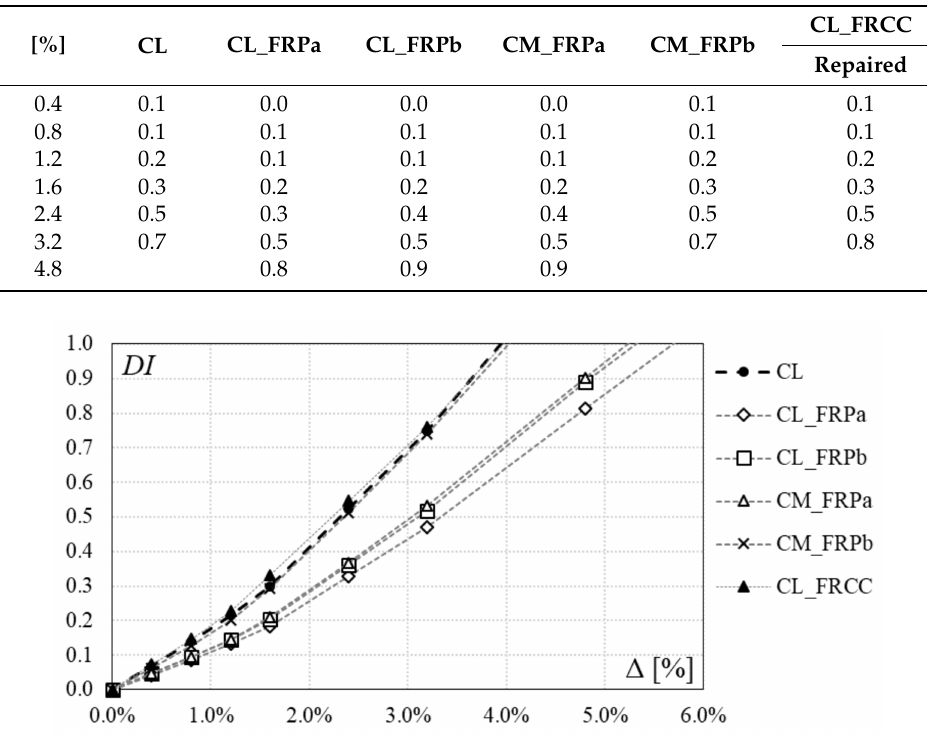
Figure 19. Damage